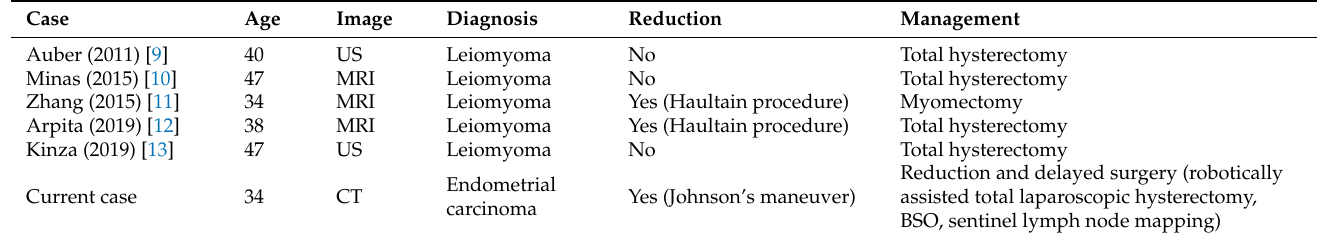
Table 2. Uterine inversion managed by laparoscopic